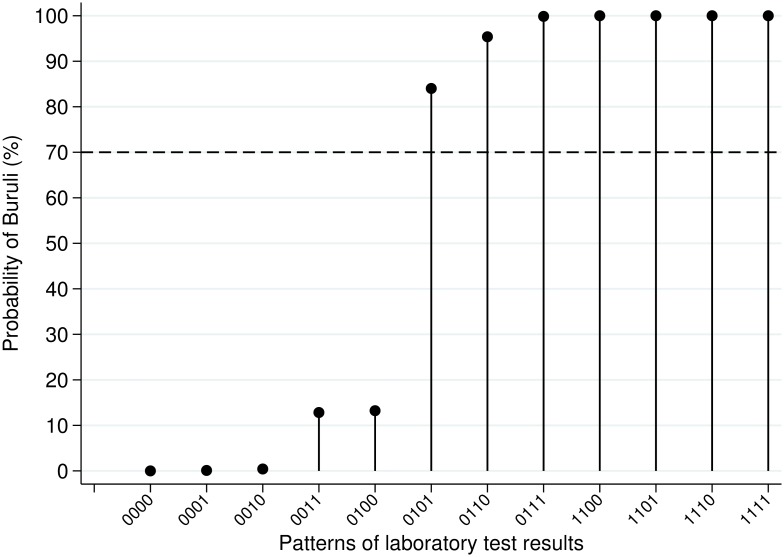
Estimated probability of Buruli ulcer according to pattern of laboratory test results in latent class model (1 = positive result, 0 = negative result; test order ZN CPC, PCR, culture, ZN Akonolinga.Dashed line: 70% probability of Buruli ulcer (predefined treatment threshold).